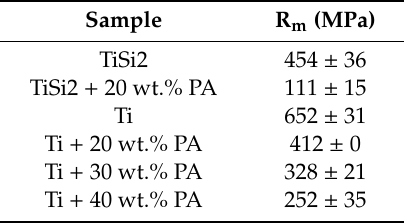
Table 4. Strength of studied alloys during three-point flexural